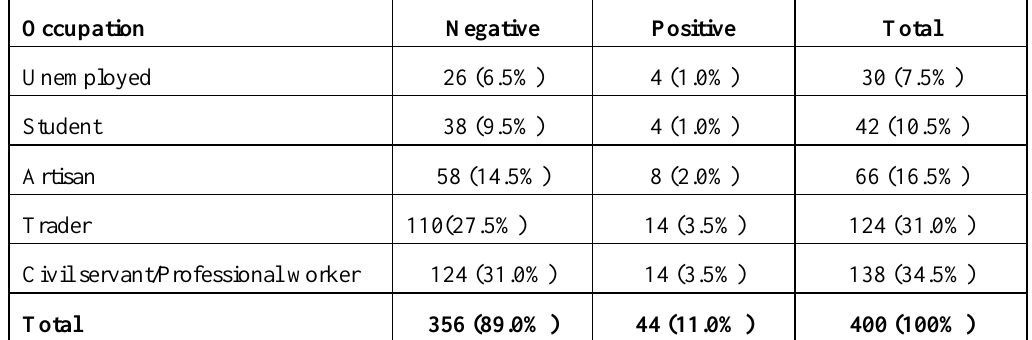
Table 7. Association between occupation and hepatitis status among pregnant women in